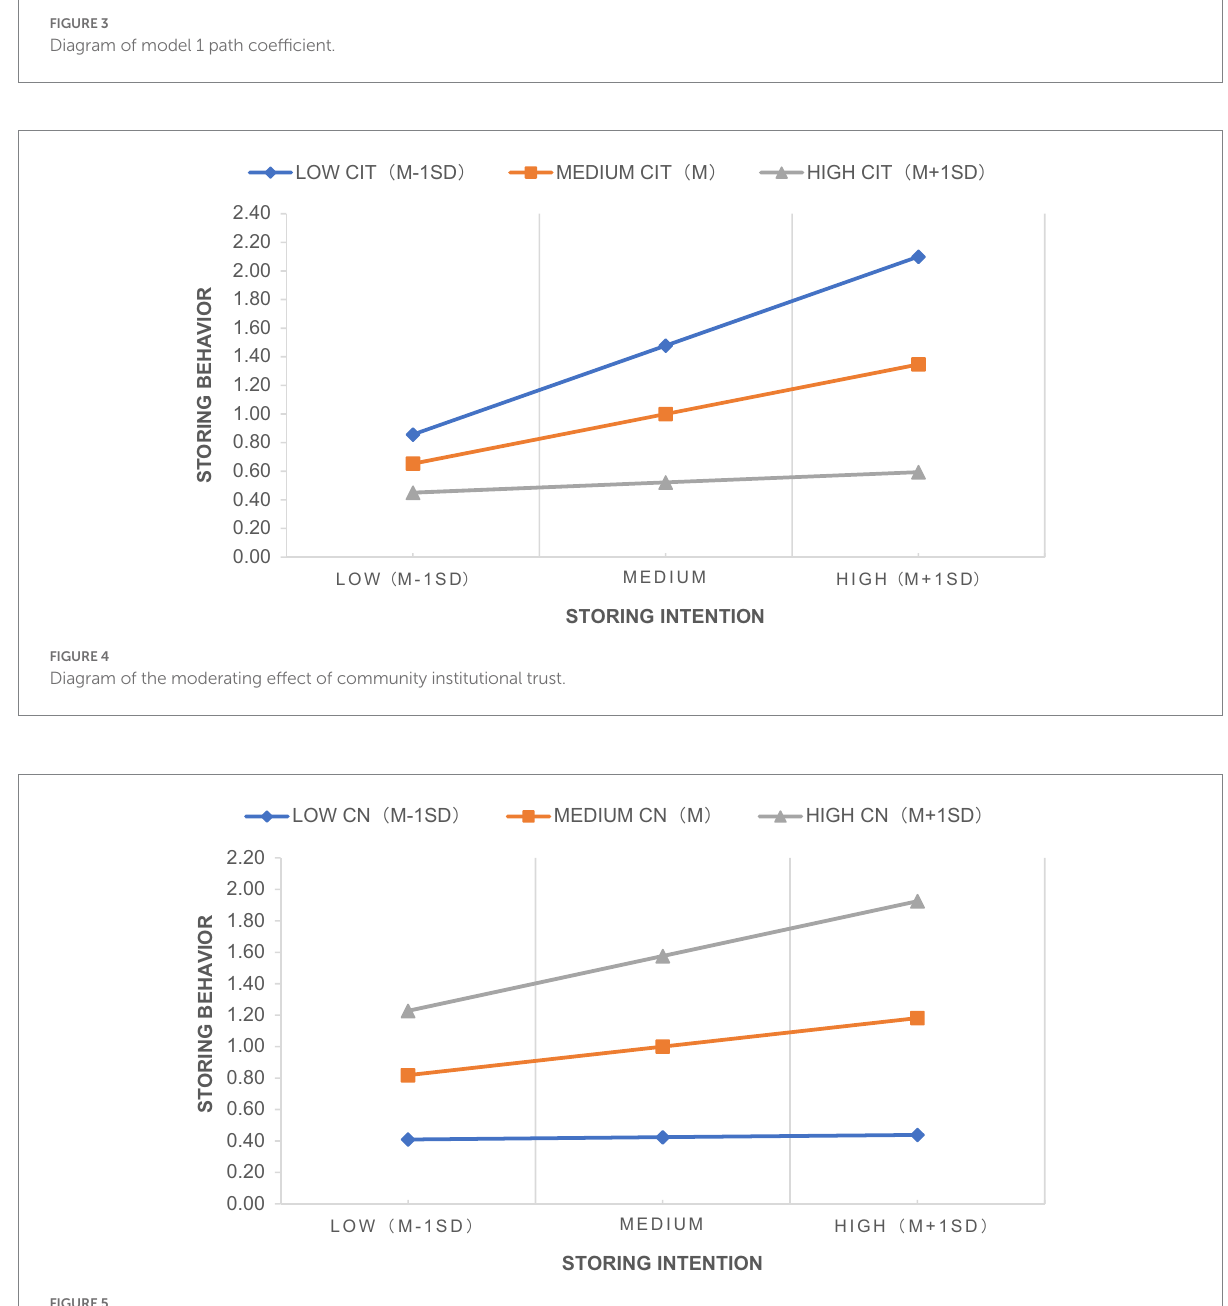
FIGURE 5 Diagram of the moderating effect of community